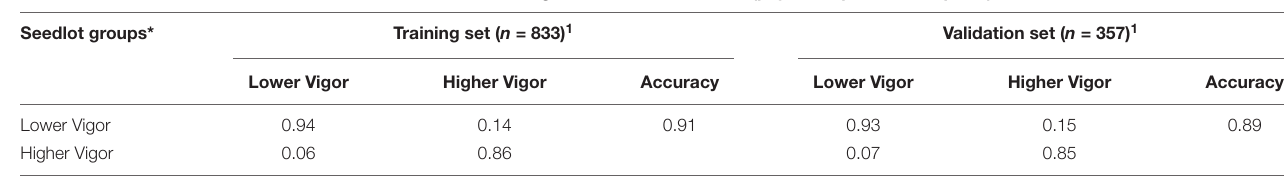
TABLE 1 | Quadratic discriminant analysis (QDA) based on physical optical descriptors, pigments and reflectance of peanut seedlots ( Arachis hypogaea L.; cv. IAC OL3) for groups of lower and higher vigor. Predictor variable: area, length, width and CIELab L * (physical optical